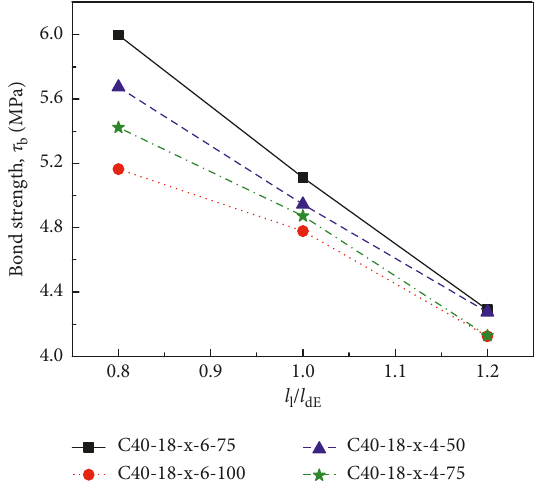
Figure 6: Bond strength-lap length relationship.